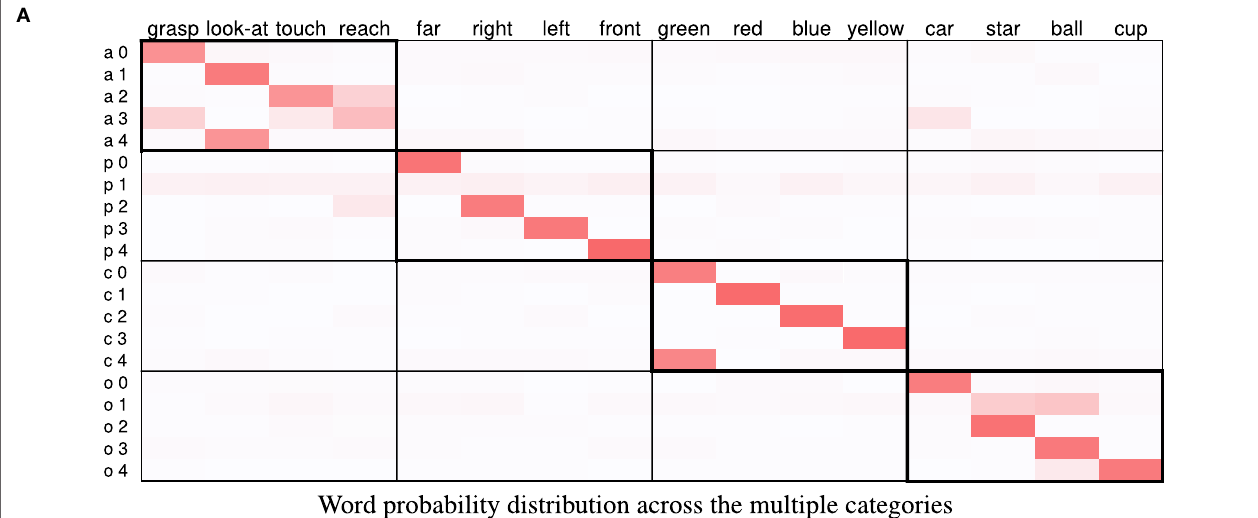
Frontiers in Neurorobotics |